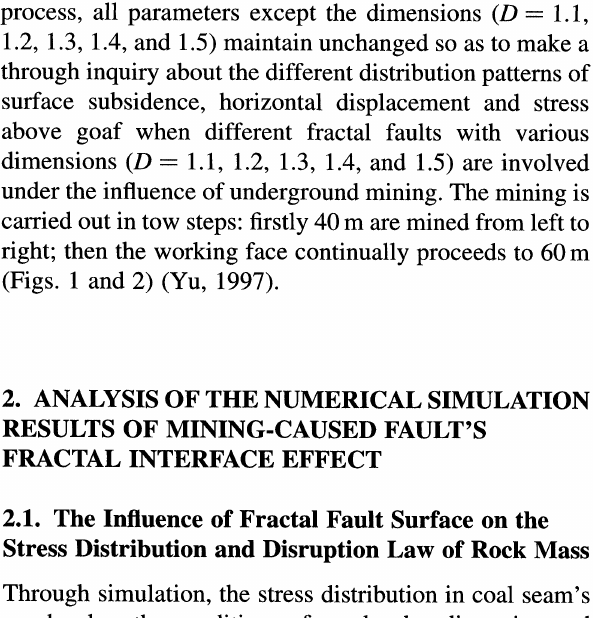
FIGURE Distribution of tensile stresses in the Y direction. In this figure, the unit of stress is: 105 Pa. process, all parameters except the dimensions (D-- 1.1, 1.2, 1.3, 1.4, and 1.5) maintain unchanged so as to make a